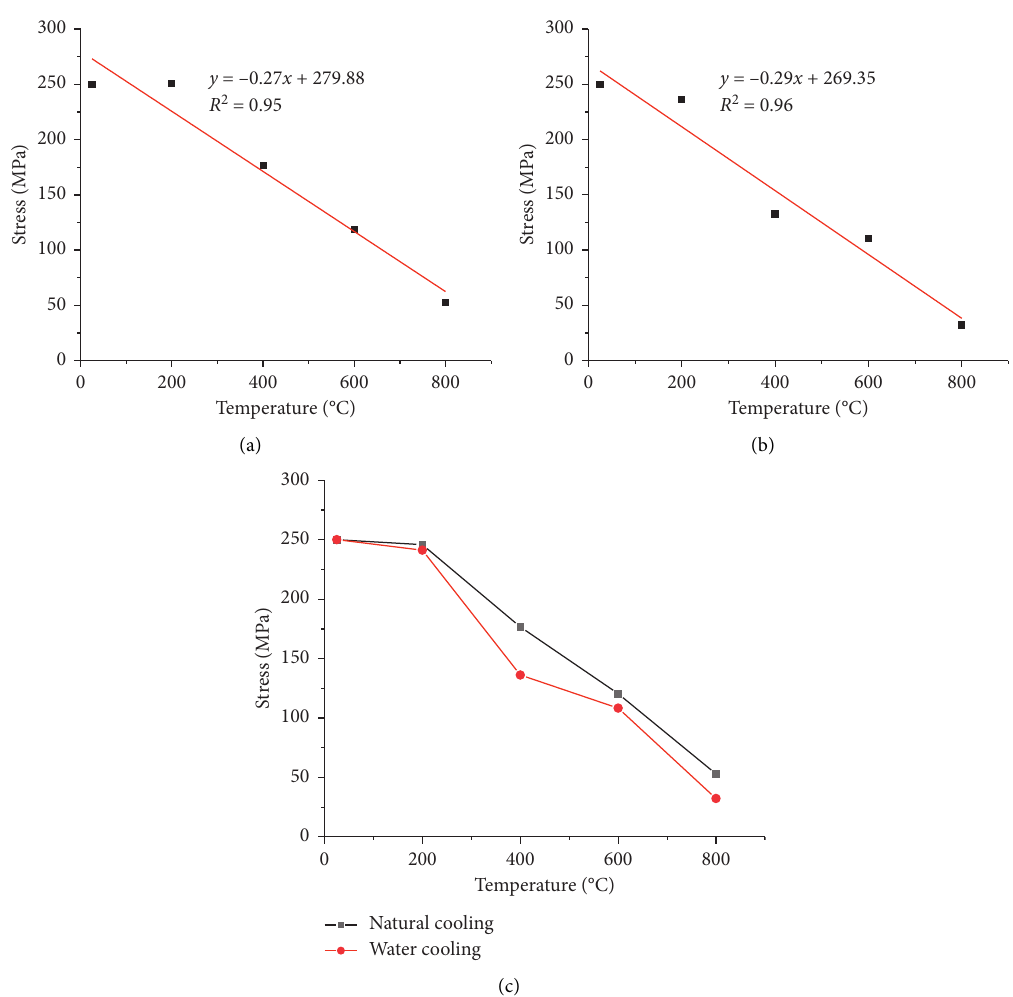
Figure 8: Relationship between peak stress and temperature (natural cooling and water cooling). (a) Natural cooling; (b) water cooling; (c) effect of cooling mode on peak stress of Skarn.